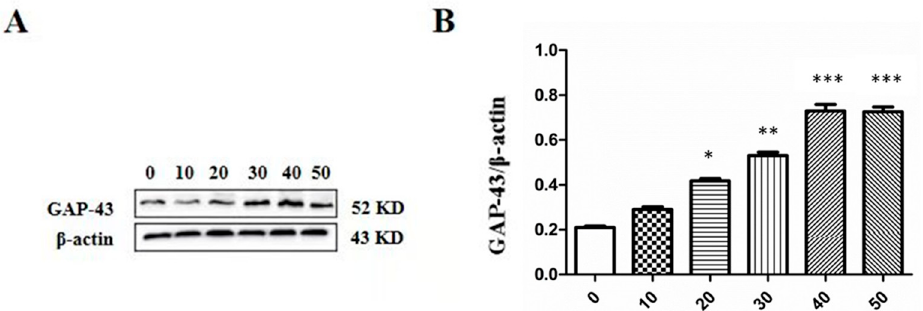
Figure 6. Effect of LTC-1 on the protein expression of GAP-43 in PC12 cells. ( A ) Proteins in PC12 cells were analyzed by Western blot analysis. ( B ) The relative optical density was normalized to β -actin. Quantitation of GAP-43 protein levels in the PC12 cells of LTC-1 six independent experiments. The data are presented as the mean ± SD (n = 3). One-way ANOVA was used for statistical analysis, followed by Tukey’s multiple comparison test, * p < 0.05, ** p < 0.01, *** p < 0.001 vs. control.